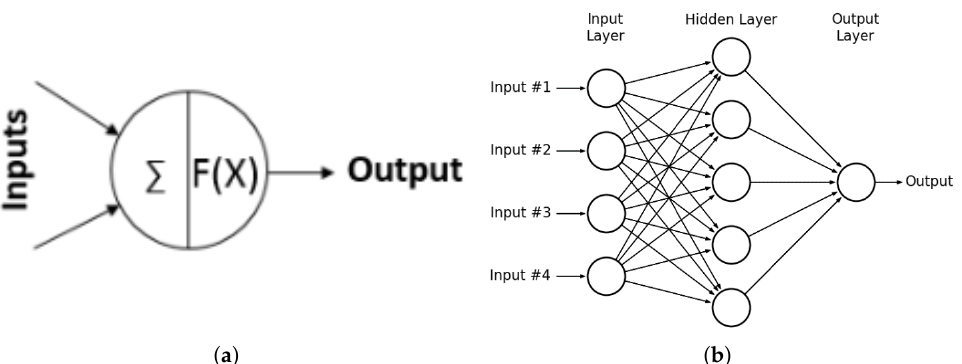
Figure 1. A neuron structure and sample ANN Multi-layer perceptron structure [21,22]. ( a ) A neuron structure; ( b ) Sample ANN